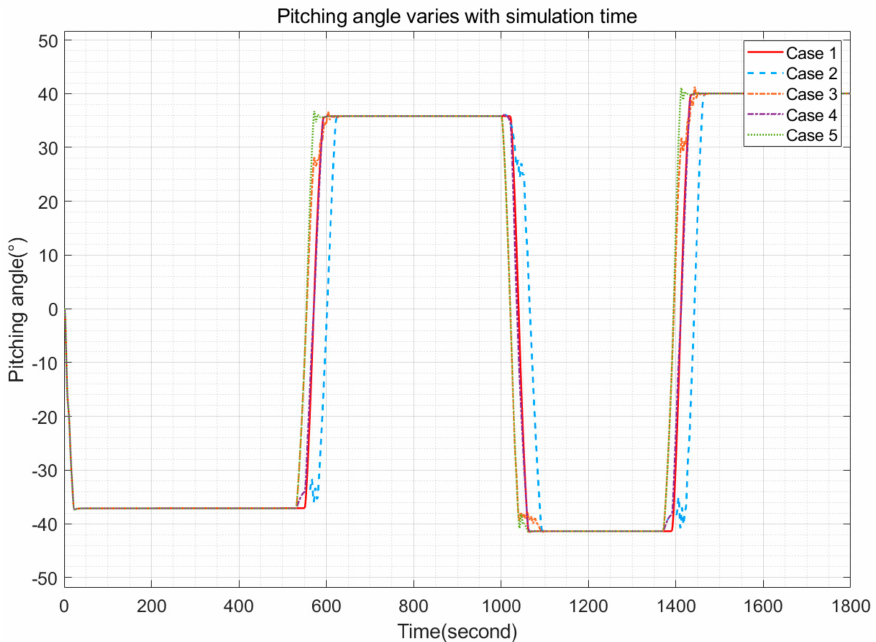
Figure 10. Pitching angle varies with simulation time. The relationship among the attitude angle, buoyancy engine, and movable mass was obtained from the motion simulation (see Figure 11). The AOA changed with the buoyancy and movable mass when the UG glided downward and upward. The horizontal coordinate in the figure indicates the displacement of the piston, i.e., the positive and negative regions represent the piston drawing inward and draining outward, respectively. The legend of the figure shows the displacement of the movable mass. The left-half plane indicates that the glider glides upward and the movable mass moves backward, whereas the right-half plane indicates that the glider dives downward and the movable mass moves